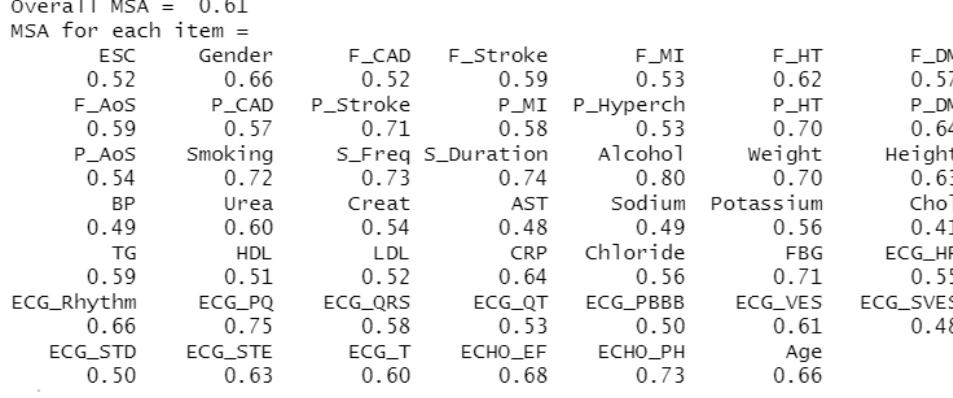
Figure 5. Representation of KMO and MSA values for monitored attributes.